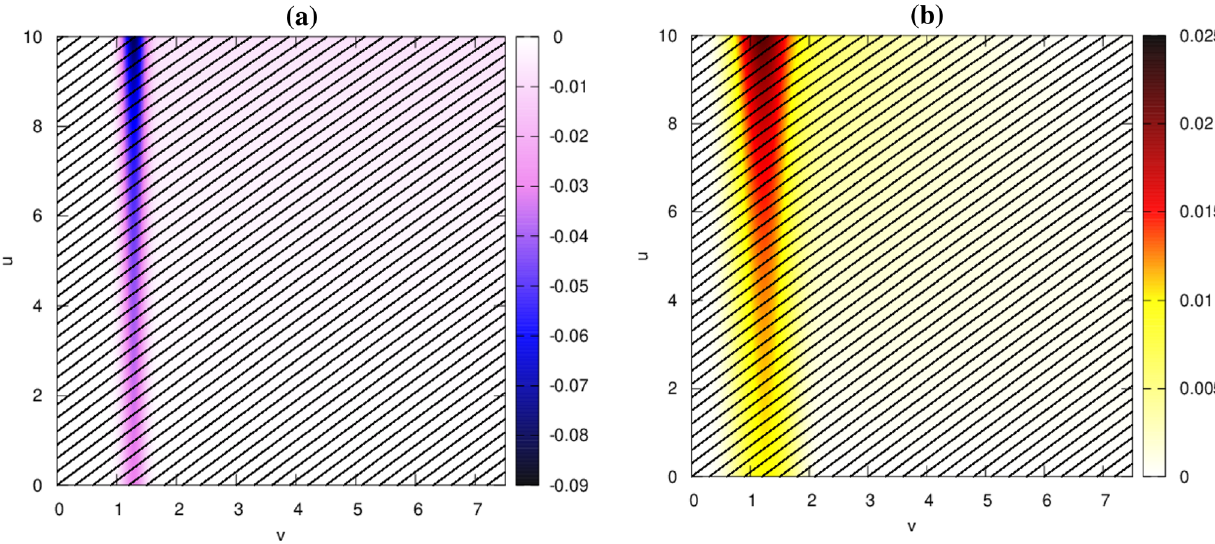
Fig. 6 The (v u ) -distribution of a the neutral scalar field, h , and b the moduli of the complex scalar field, | X | , for the same parameters as in Fig.